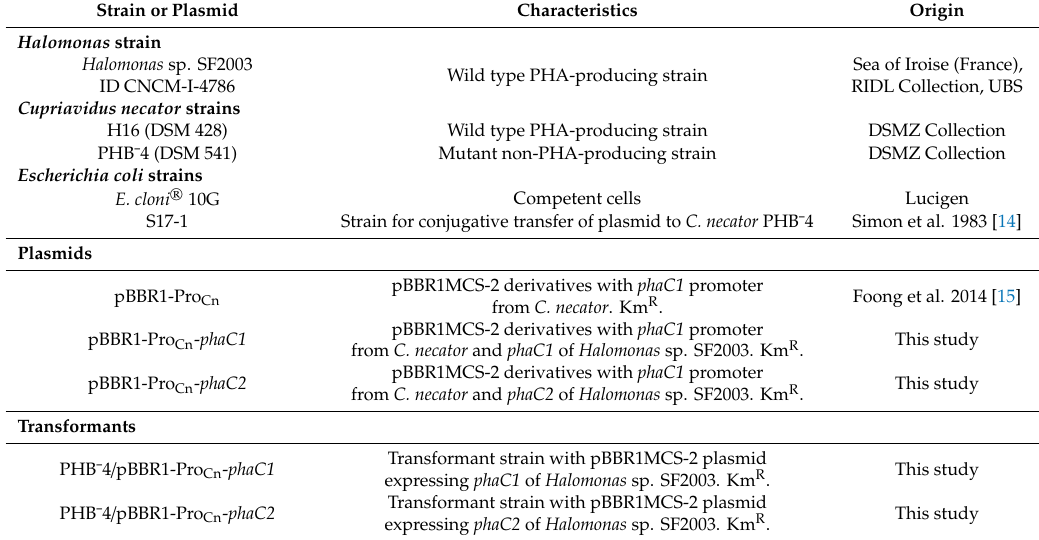
Table 1. List of plasmids and bacterial strains used in this study. DSMZ: Leibiz Institute DSMZ-German Collection of Microorganisms and Cell Cultures. Km R : Resistance to kanamycin, RIDL: